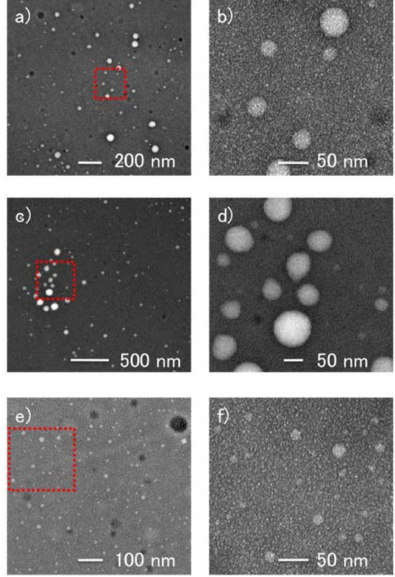
Figure 3. TEM images of UBD-1 ( a , b ), -2 ( c , d ), and -3 ( e , f ). The right panels ( b , d , f ) show enlarged images of the red dotted squares in left